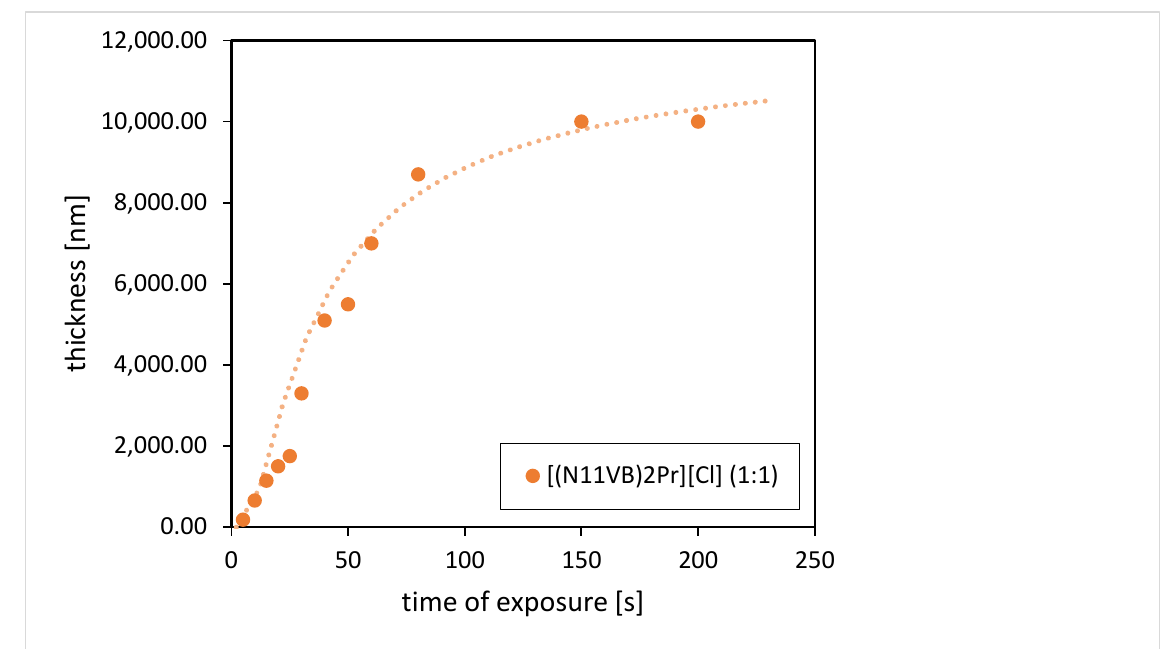
Figure 6. IL-resist contrast curves for photodefinable [(N 11 VB) 2 Pr][Cl] (1:1) .